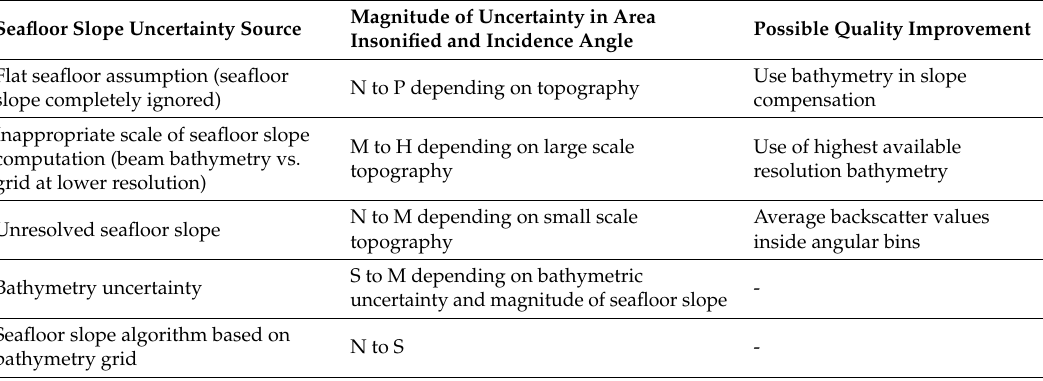
Table 4. Major sources of uncertainty for seafloor slope required for area insonified and seafloor incidence angle. See the code (N-S-M-H-P) definition in Table